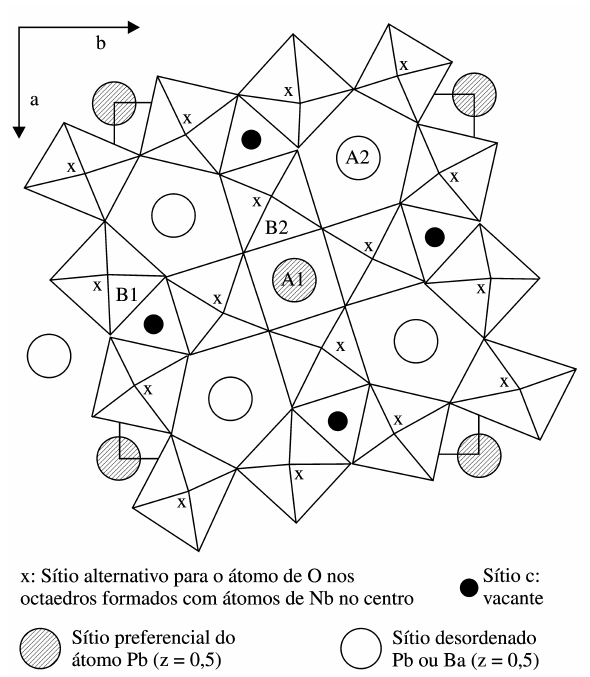
Figura 1. Célula unitária tungstênio bronze com simetria tetragonal (4/mmm). Os sítios B1, B2, A1, A2 e C estão destacados 2